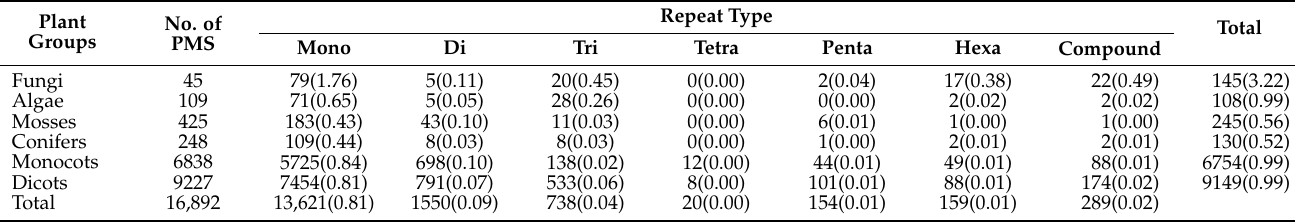
Table 2. Number of pre-microRNA sequences (PMS) and absolute and relative numbers of simple sequence repeats in different plant taxonomic